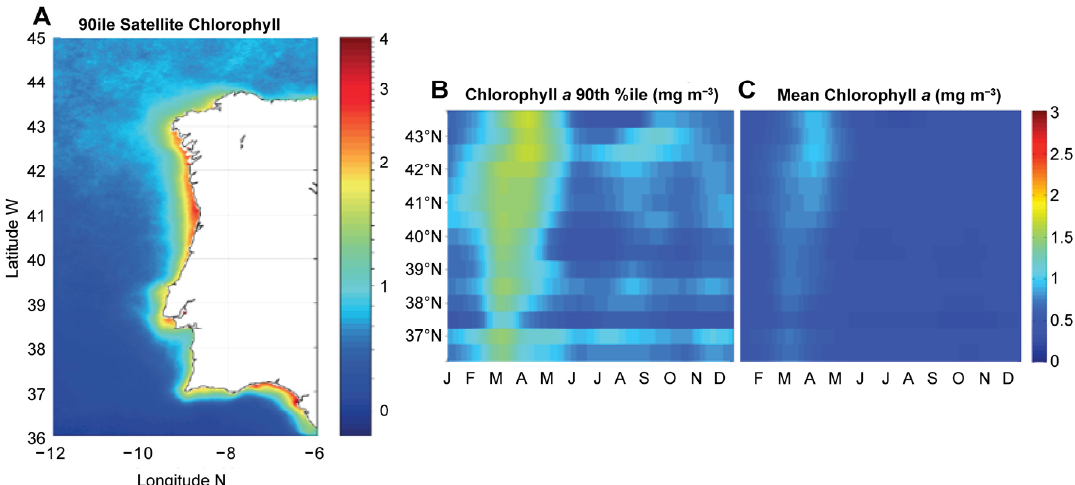
Figure 5. Satellite Chl a P90 annual climatology ( A ) at the Western Iberia region, from CCI data products (1998–2016; mg m − 3 ); seasonal and latitudinal (0.5° resolution) variation of chlorophyll a P90 ( B) ; mg m − 3 and mean concentrations ( C ) mg m − 3 . Please note that in plots B and C, each observation represents the result of integrating all data points, within each 0.5° N latitudinal band, at a given time.